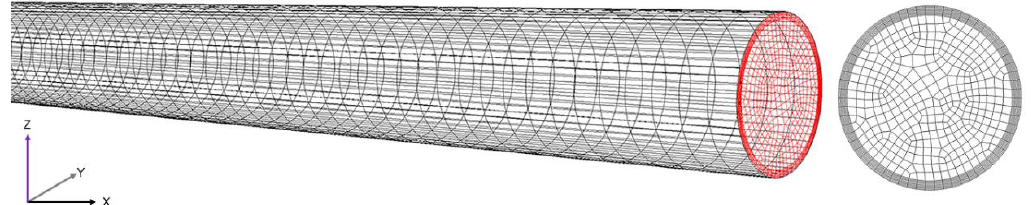
Figure 1. Pipe geometry and grid system for the numerical simulation.